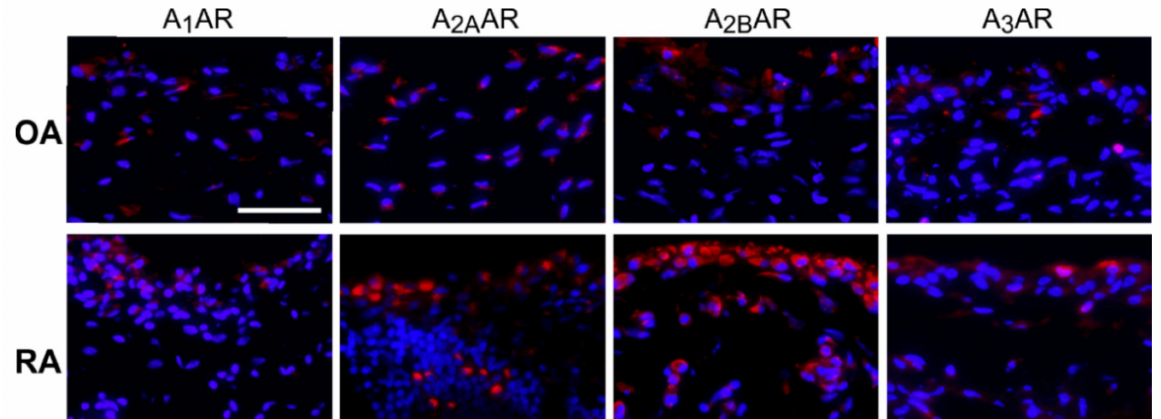
Figure 3. Expression of adenosine receptors (ARs) in the synovium. Representative fluorescent micrographs of OA and RA synovial tissues immunostained for A 1 -, A 2A -, A 2B -, and A 3 AR (red) and counterstained for nuclei with DAPI (blue) (bar: 50 µ m). Abbreviations: see legends to Figure